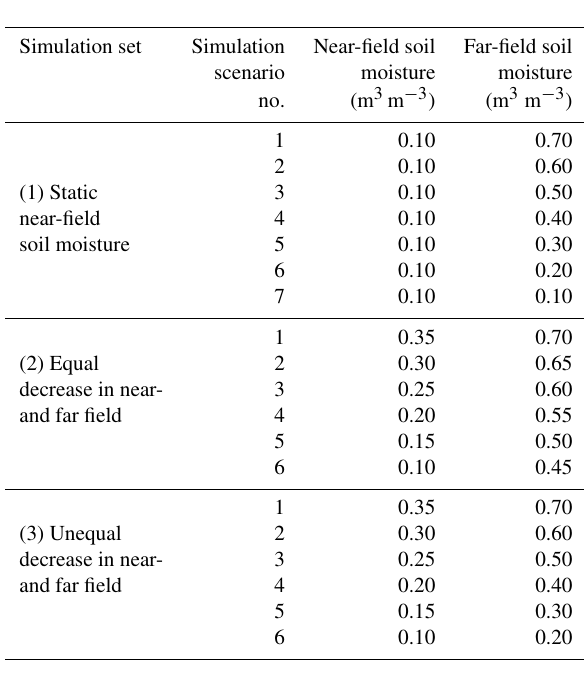
Table 1. Overview of the different Monte-Carlo-based neutron transport simulation scenarios conducted within the different sim- ulation sets. Near-field soil moisture refers to soil moisture in areas covered with mineral soils, while far-field soil moisture refers that in the peatland soils.